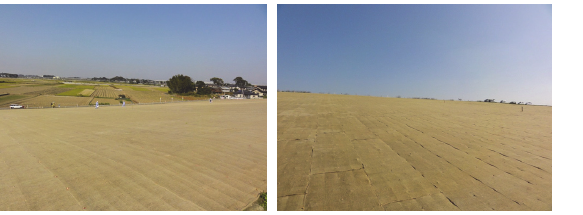
Figure 4. Control points and check